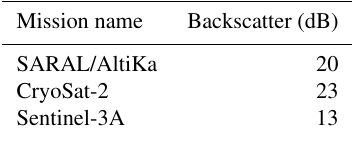
Table 2. Backscattering